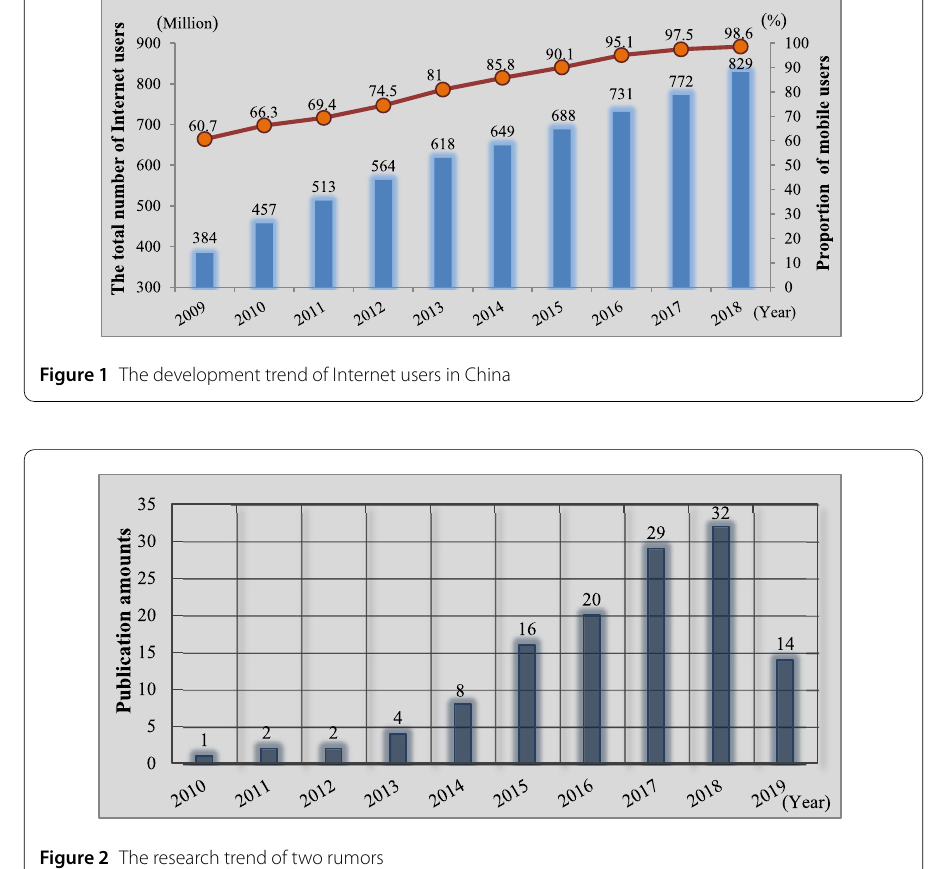
Figure 2 The research trend of two